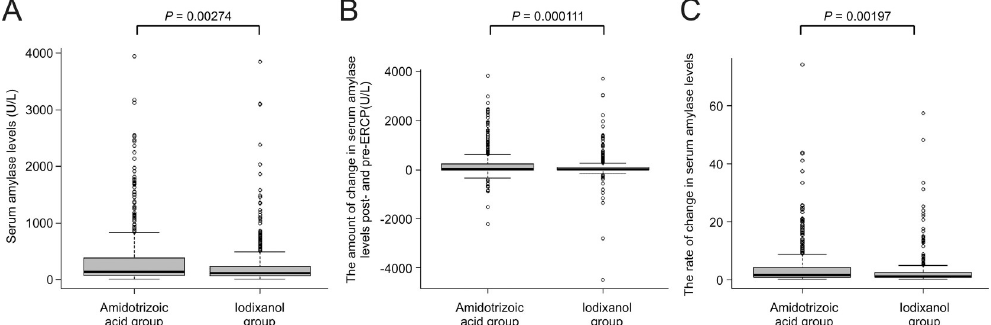
Fig 1. (A) Serum amylase levels post-ERCP in the amidotrizoic acid and iodixanol groups prior to propensity score matching. ( B) The amount of change in serum amylase levels post- and pre-ERCP (post-ERCP amylase levels were subtracted from pre-ERCP amylase levels) in the amidotrizoic acid and iodixanol groups. (C) The rate of change in serum amylase levels post- and pre-ERCP (post-ERCP amylase levels were divided by pre-ERCP amylase levels) in the amidotrizoic acid and iodixanol